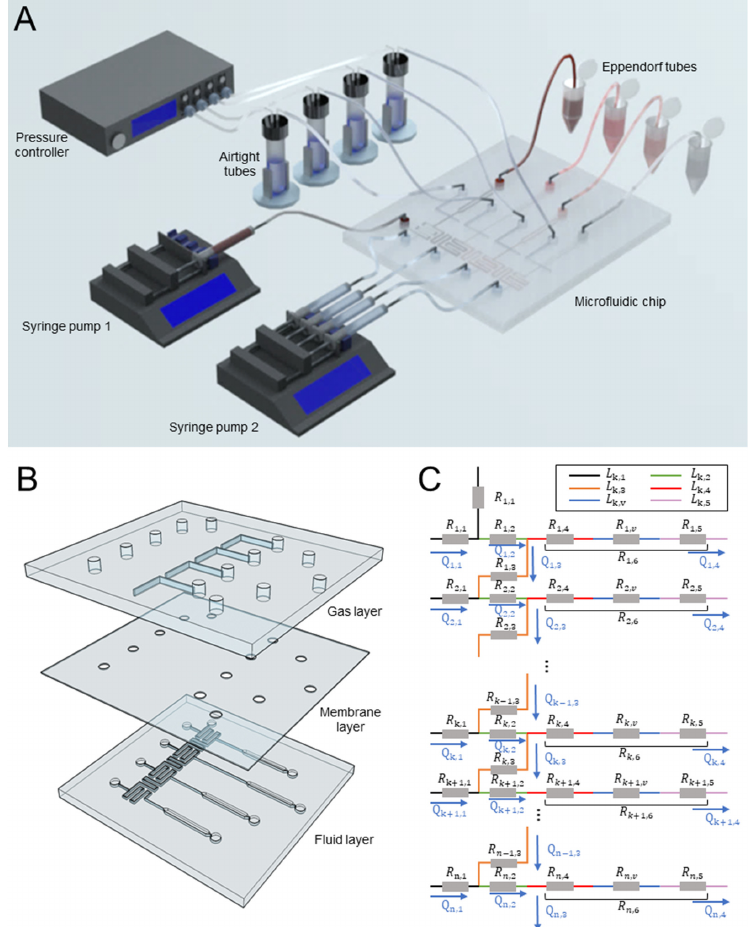
Figure 1. The microfluidic system for dynamic generation of concentration profiles in four parallel channels. ( A ) The schematic of the experimental platform consisting of a pressure controller, two syringe pumps, and a microfluidic. ( B ) The explosion view of the device with the gas, membrane, and fluid layers. ( C ) An equivalent circuit of the chip with n branch channels.